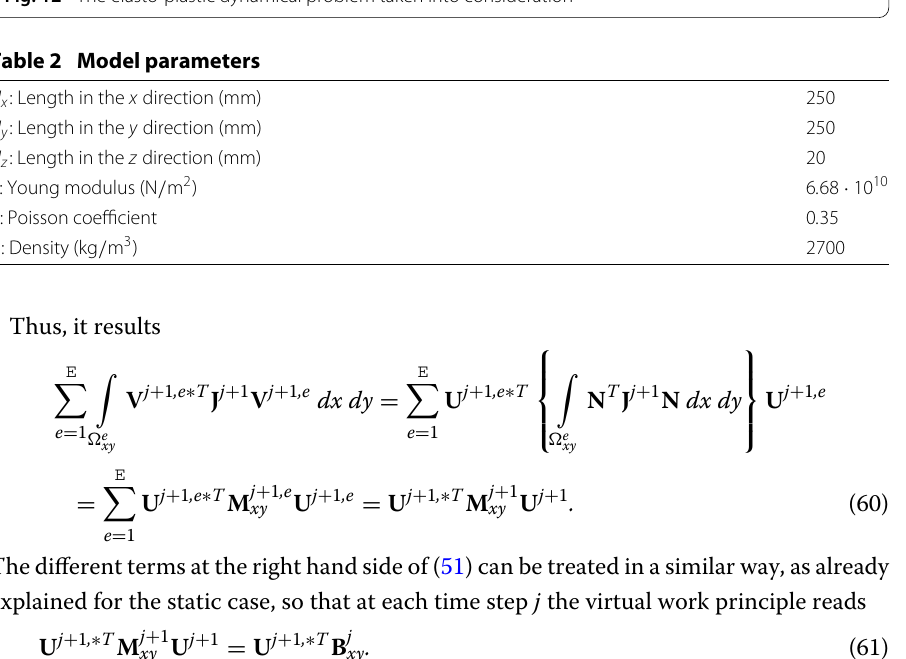
Table 2. On the right boundary face of the domain (the blue zone in Fig. 12) an horizontal traction is enforced, T = (2 . 7 · 10 8 , 0 , 0) N / m 2 and on the opposite face homogeneous Dirichlet boundary conditions are imposed. No volumetric body forces are